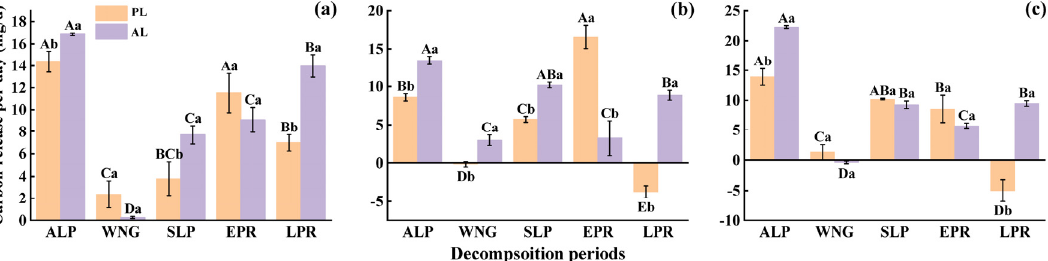
Figure 6. The daily carbon release of goldenrain tree ( a ), camphor tree ( b ), and weeping willow tree ( c ) foliar litter during different critical periods. ALP, WNG, SLP, EPR, and LPR indicate the autumn litter peak period, winter non ‐ growing season, spring litter peak period, early plum ‐ rainy season, and late plum ‐ rainy season, respectively. PL and AL indicate physiological and abnormal litter, re ‐ spectively. Different capital letters indicate significant differences between different critical periods ( p < 0.05). Different small letters indicate significant differences between different sources of foliar litter ( p < 0.05).